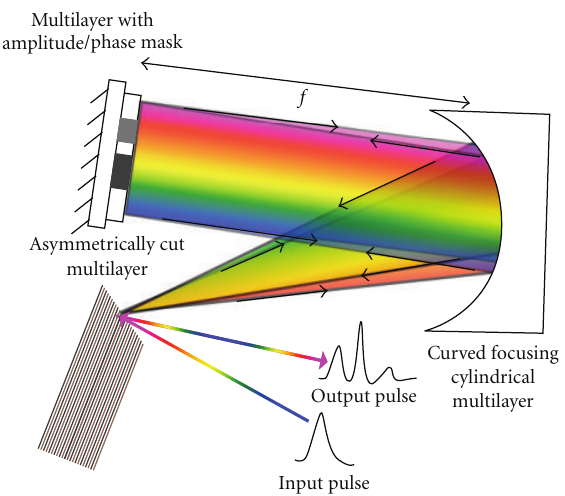
Figure 1: This is the proposed X-ray equivalent of the folded 4f geometry already demonstrated in the visible regime. It consists of a thick asymmetrically cut multilayer acting as a high-e ffi ciency grating, a focusing multilayer mirror, a movable mask to shape the pulse and, a normal incidence multilayer to enable the folded 4f